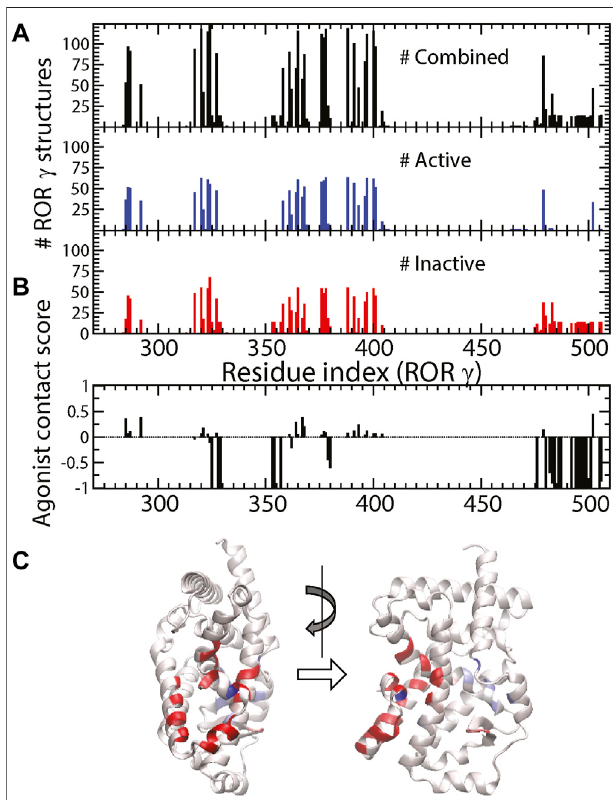
FIGURE 3 | (A) The total number of ligand-protein contacts made by a speci fi c residue (black), the number of ligand-protein contacts in active and inactive structures (blue and red). (B) The agonist contact score is displayed asafunctionofresidue. (C) Thecorrespondingvaluesfrom (B) arecolor- labeled onto the 3D structure of ROR γ (front and side